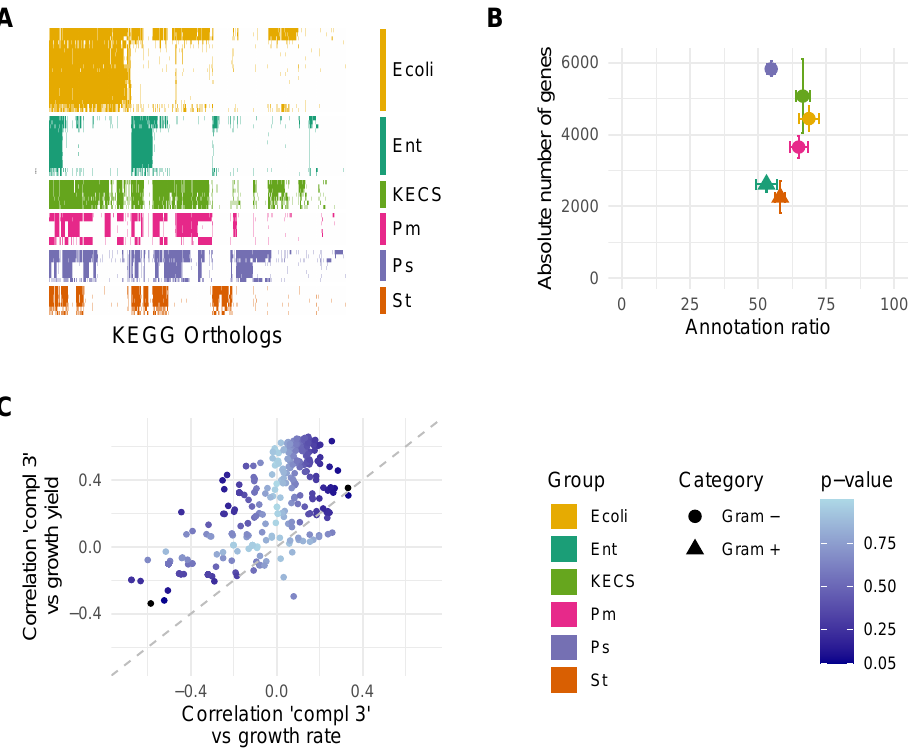
Figure 1. ( A ) Heatmap of presence (coloured) or absence (white) of KEGG Orthologs in the different bacteria groups. Although most KOs are present in the KECS group, other groups lack many. Note that only the KOs that are present in at least one organism are shown. ( B ) Although the absolute number of genes in the genome of each group varies per group, their annotation ratio from genome to KOs remains similar around 60%. The groups St and Ent have notoriously less genes and, thus, less absolute number of KOs than the rest of the groups. ( C ) Comparison of the relation of ‘Complementarity 3’ with the increase in two different growth measures: yield and rate (from [5]). The correlation is higher, for most pathways, when calculated against growth yield. An overview of the relation of all calculated indices with growth rate and yield is presented in Figure